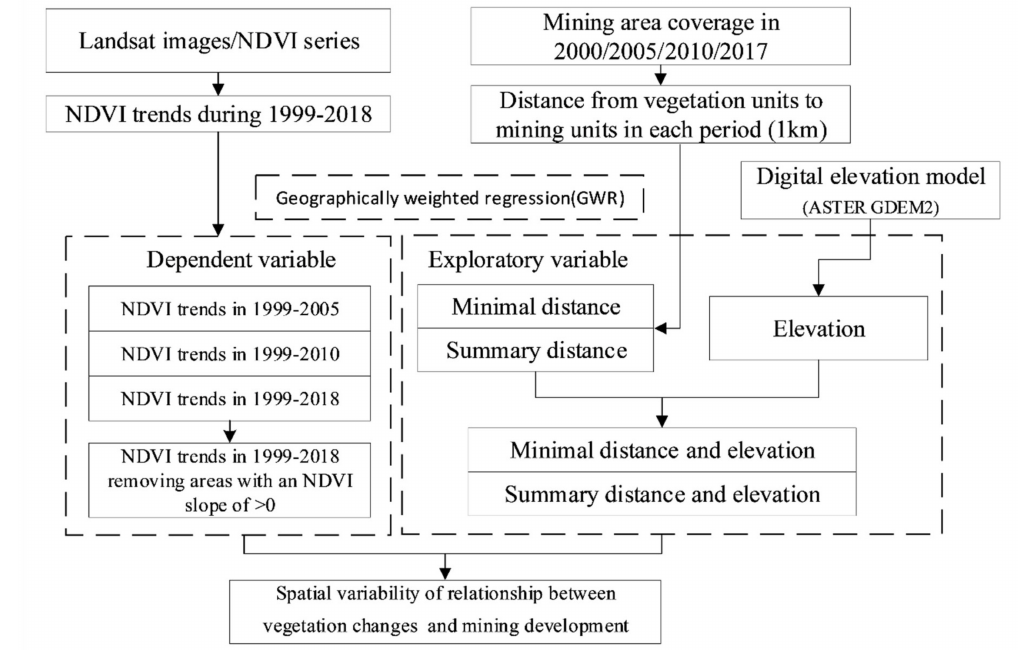
Figure 2. Framework of data processing